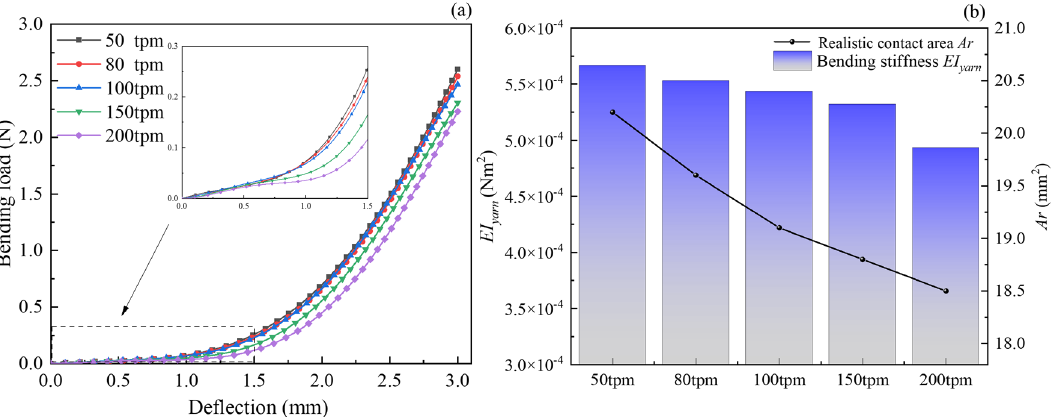
Figure 8. Prediction of bending behavior of twisted yarn: ( a ) curve of deflection and bending load, ( b ) realistic contact area and bending stiffness for different twisted yarns at a deflection of 3 mm.